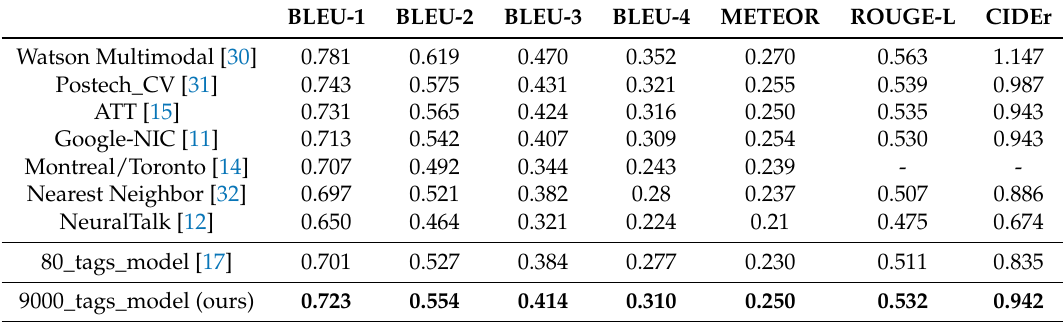
Table 4. Results of our models compared to other methods.